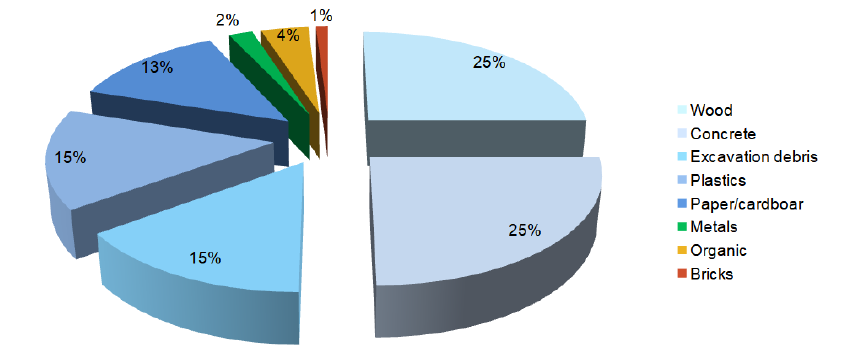
Figure 4. Waste classification in the project